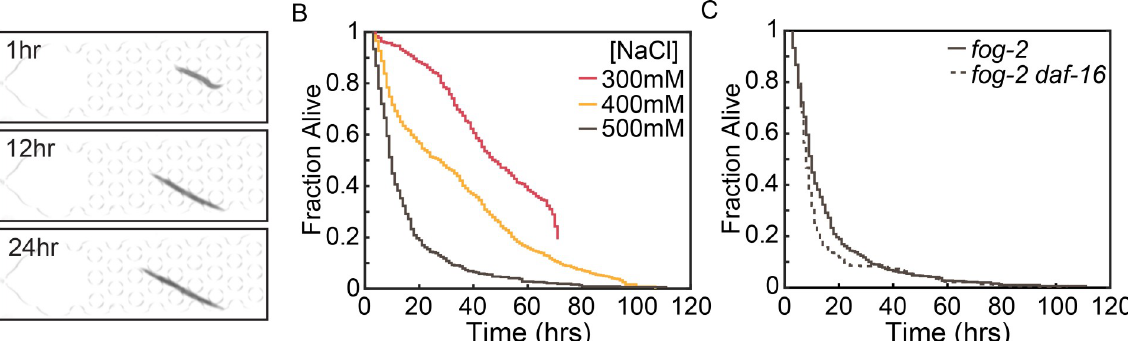
Fig 6. Osmotic stress. (A) Images of a representative fog-2 ( q71 ) animal at 1, 12, and 24hrs showing the characteristic squat worm phenotype at NaCl application, and recovery over time. (B) Lifespan curves for fog-2 ( q71 ) animals in M9 buffer supplemented with increasing concentrations of NaCl (Number of animals = 297 (300 mM), 792 (400 mM), 508 (500 mM)). Log-Rank p < 0 . 0001 . (C) Comparison of fog-2 ( q71 ) and fog-2 ( q71 ) daf-16(mgDf47) animals at 500 mM NaCl (Number of fog-2 ( q71 ) daf-16(mgDf47) animals is 450). Log-Rank p = 0 . 0005 .